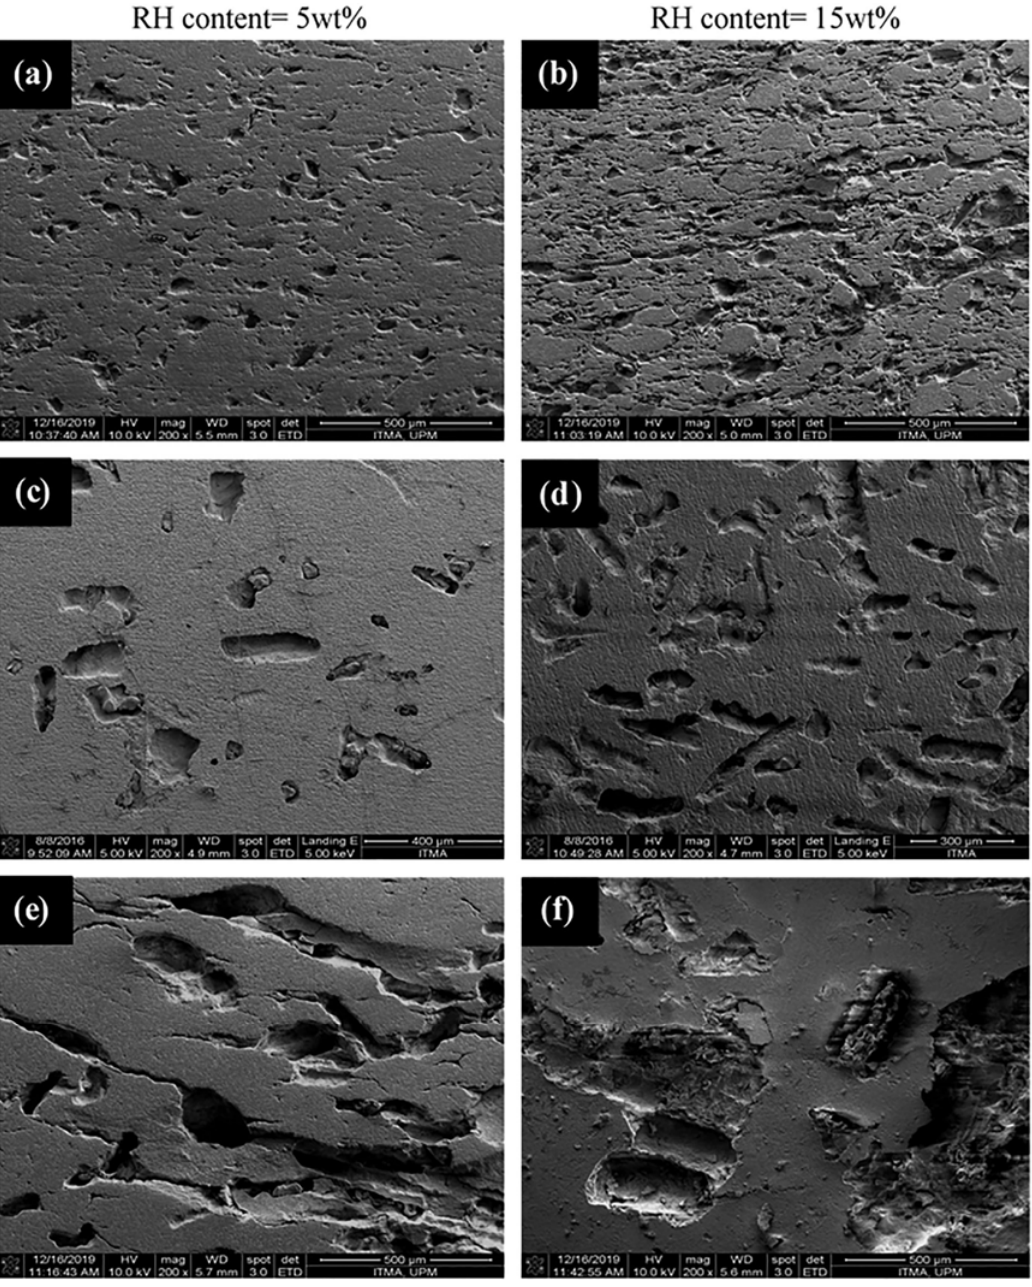
Figure 4. FESEM microstructures of porous Al 2 O 3 prepared using ( a , b ) <63 µm, ( c , d ) 63–125 µm, and ( e , f ) 125–250 µm particle size ranges of rice husk.